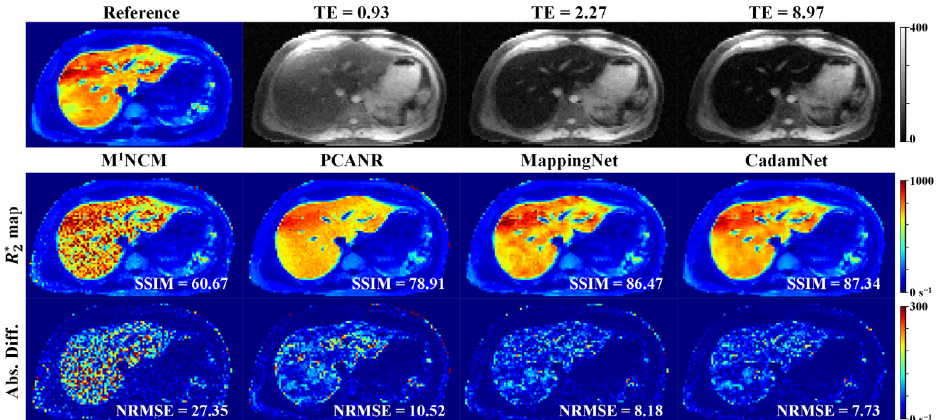
Figure 4. R2* maps for the simulated testing dataset with Rician noise ( σ g = 9). Top: Reference of R2* map and simulated noisy T2*-weighted images at three different echo times (ms). Bottom: R2* maps reconstructed using M 1 NCM, PCANR, MappingNet, and the proposed CadamNet methods, and the absolute difference maps are shown below the corresponding R2* maps. The SSIM of each R2* map is shown in its bottom right corner, and the NRMSE is shown in the absolute difference map.